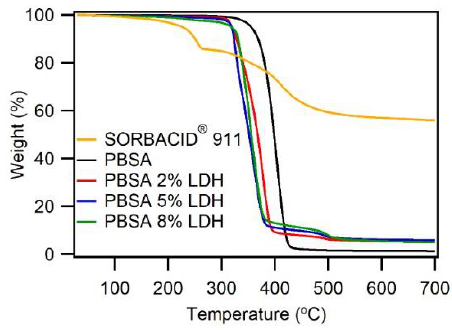
Figure 2. TG curves of SORBACID ® 911 (yellow line), PBSA (black line), and PBSA-LDH nanocomposites (red line 2%wt LDH; blue line 5%wt LDH; green line 8%wt LDH). The samples were heated from 30 °C to 700 °C, with a heating rate of 10 °C min −1 .